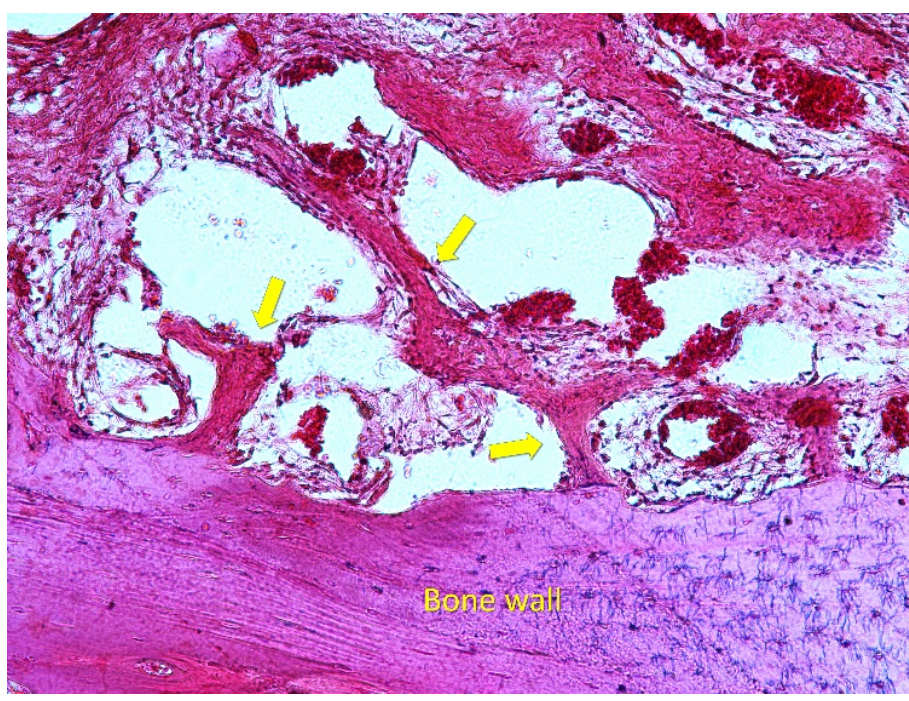
Figure 5. Healing after 2 weeks. New bone was found forming from the sinus walls in both groups. Scarlet-acid fuchsine and toluidine blue. Arrows showing new bone formation.